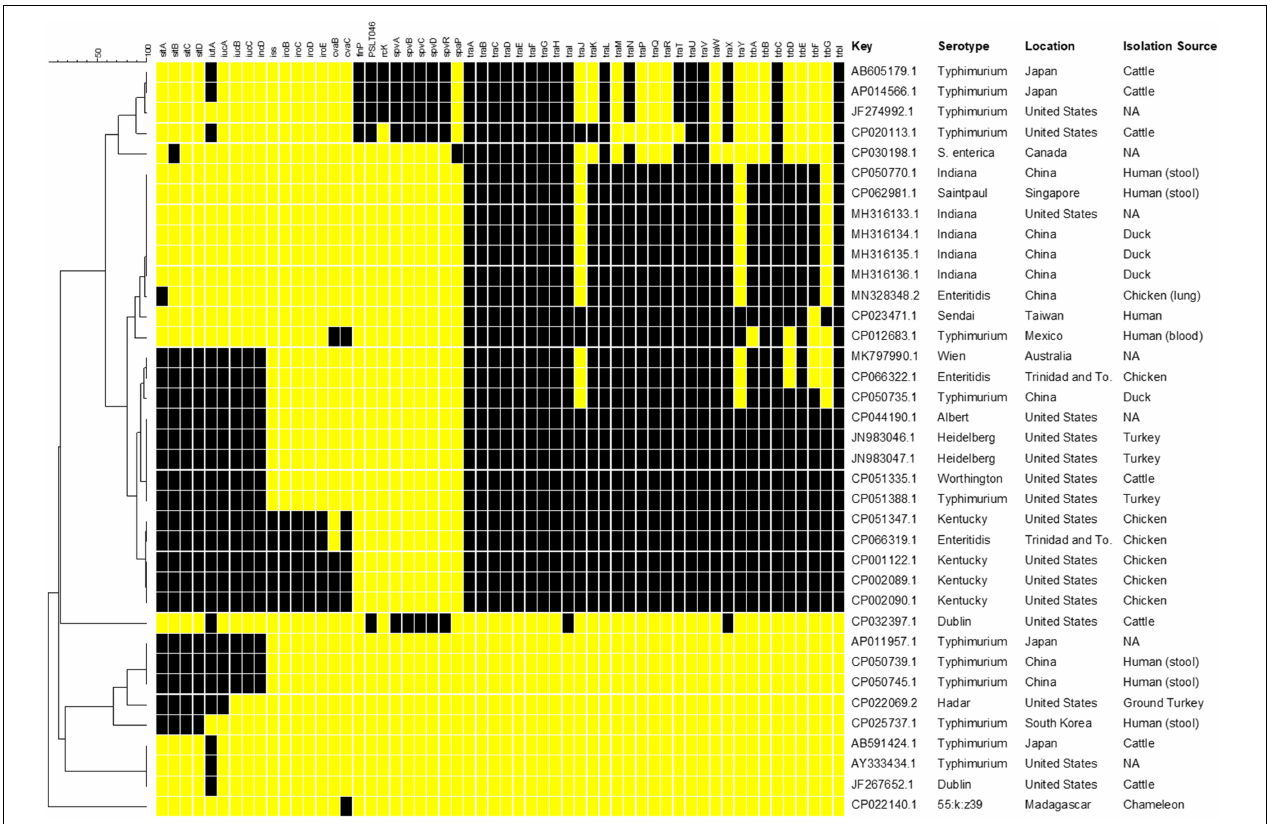
FIGURE 1 | Results of in silico genetic analyses of sequences containing the IncFIB replicon sequences. Results are shown for the following genes: plasmid-associated sitABCD, iutA, iucABCD, iss, iroBCDE, cvaBC, finP, rcK, spvABCDR, and plasmid transfer associated genes. The resultant presence (black boxes) and absence (yellow boxes) data were entered into BioNumerics and the resultant phylogenetic analyses using UPGMA analysis are shown. The column with the header “Key” includes the GenBank accession number. Information on the serotype, country of origin (Location) and host species (Isolation Source) where the Salmonella were collected was extracted from the GenBank metadata when available. Missing information is indicated by